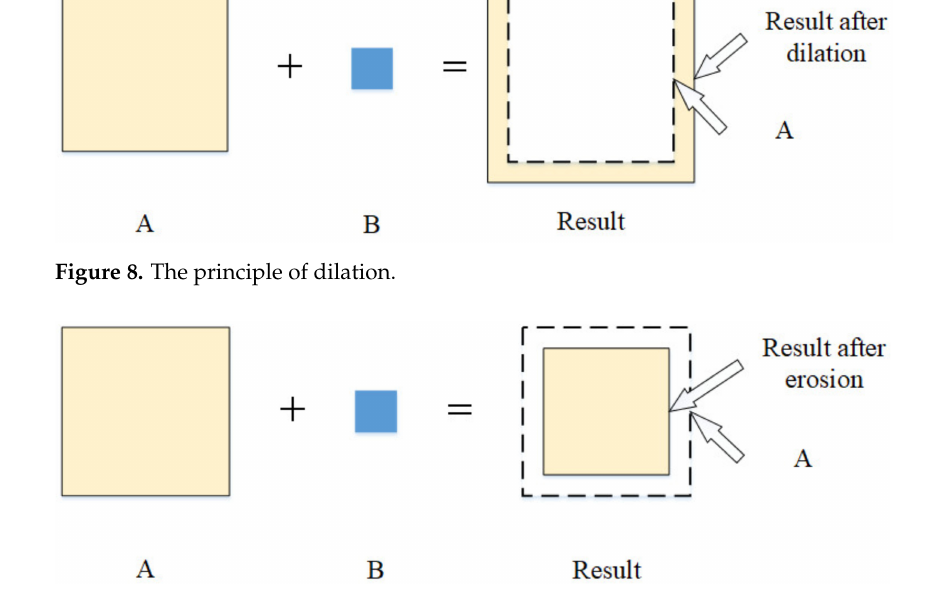
Figure 9. The principle of